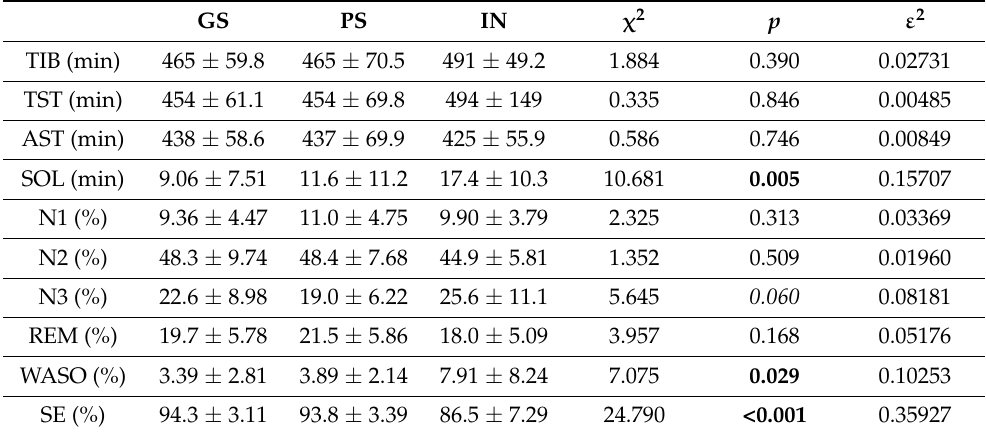
Table 2. Traditional sleep architecture parameters in the three